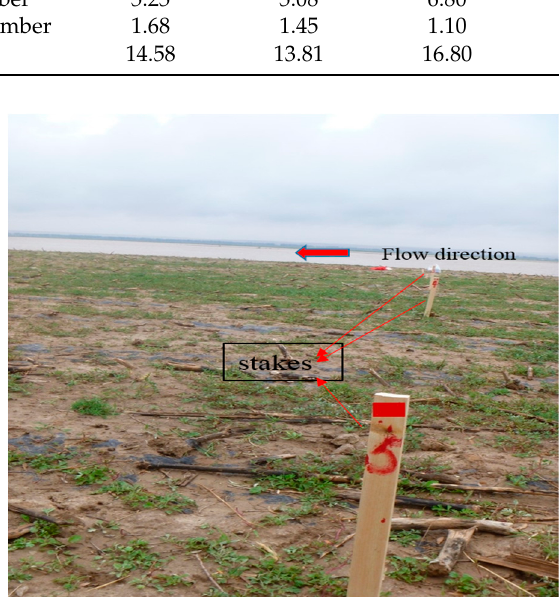
Figure 2. Collapse distance measurement for surveying Section 1.